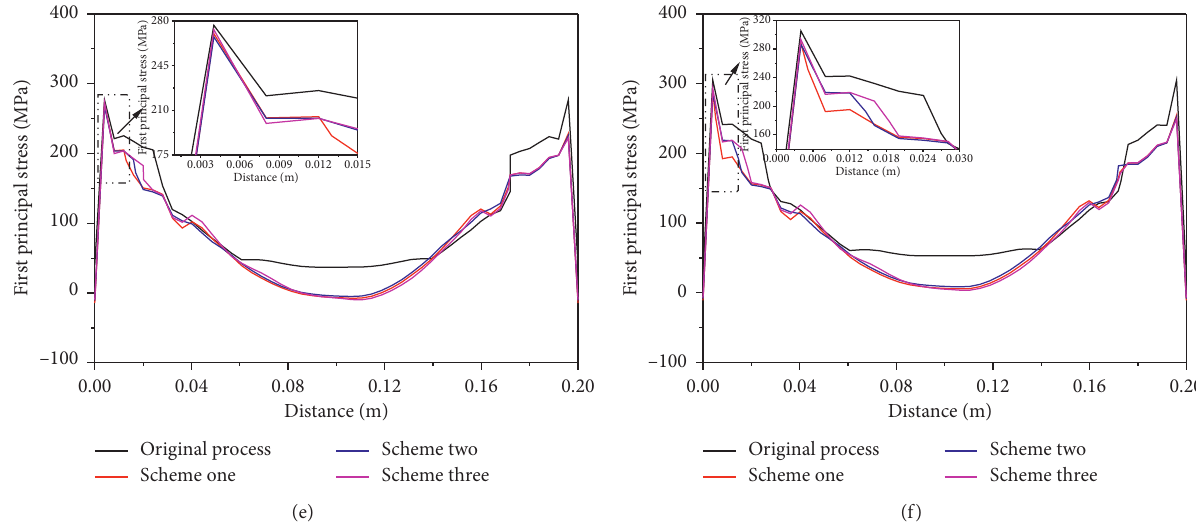
Figure 16: Comparison of the first principal stress at 6mm below the narrow surface under different water distribution schemes. (a) Outlet of zone 2. (b) Outlet of zone 3. (c) Outlet of zone 4. (d) Outlet of zone 5. (e) Outlet of zone 6. (f) Outlet of zone 7.